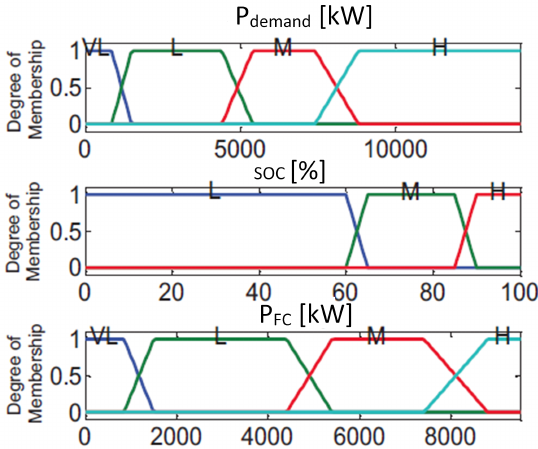
Figure 7. Membership functions for power demand, SOC , and battery